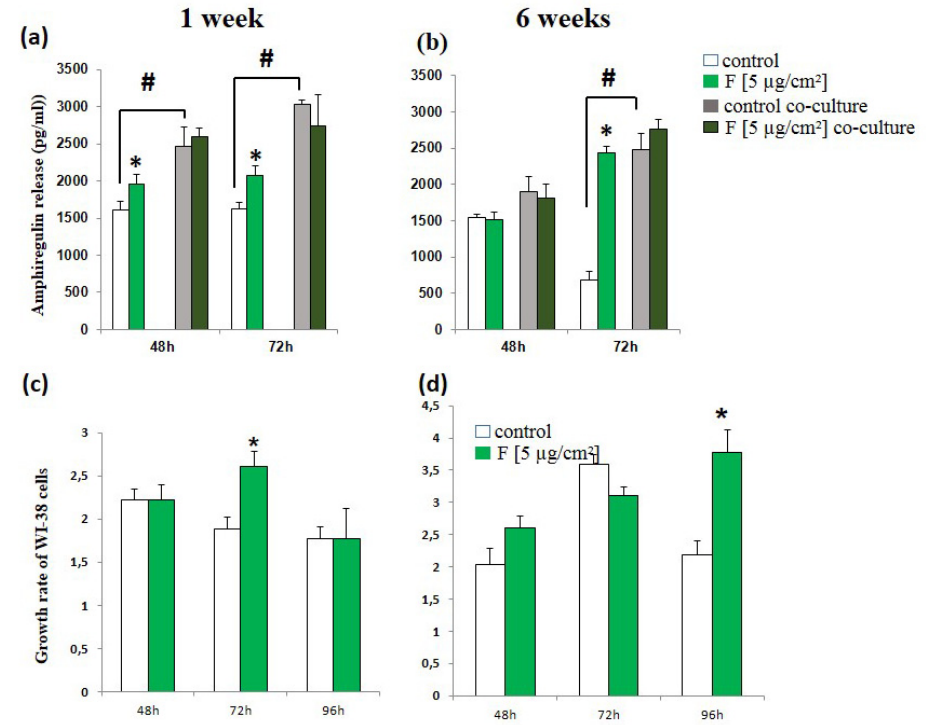
Figure 6. HBE cells-fibroblasts co-culture. ( a and b ) Amphiregulin release induced by exposure to fine PM of HBE cells co-cultured or not with fibroblasts. HBE cells were once exposed or not to fine PM at 5 µg/cm² in the 1st and 6th week of culture. Amphiregulin release was measured at 48 hours and 72 hours post-exposure in the HBE basal medium grown alone or co-cultured with fibroblasts. ( c and d ) growth rate of Wi-38 cells co- cultured with HBE cells treated or not with fine PM at 5 µg/cm². *: Different from control at the same time ( p < 0.05) #: Different from control ( p < 0.05), n =